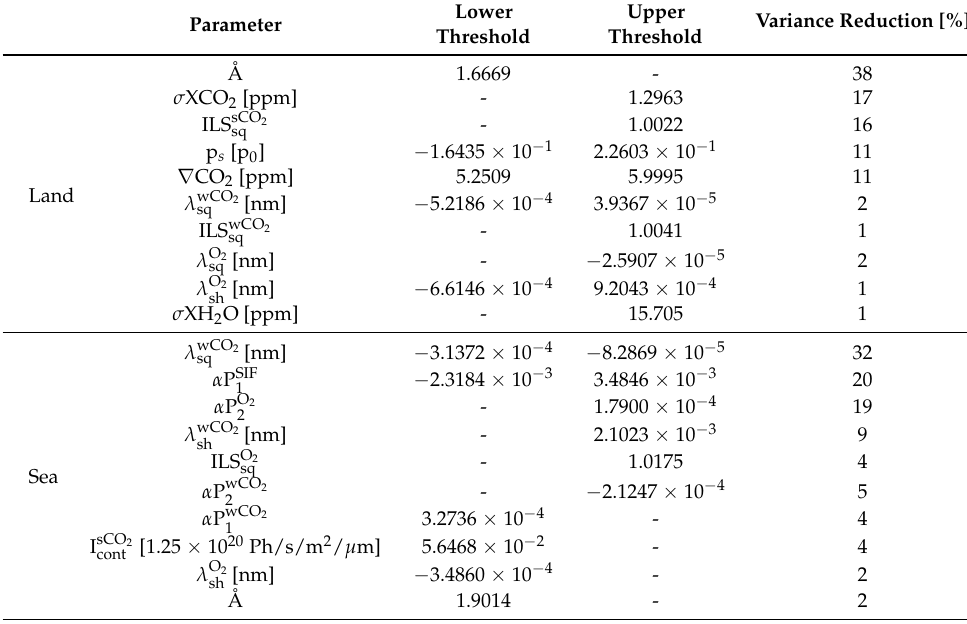
Table 1. Thresholds and prorated variance reduction of the 10 parameters of the potential outliers filter for soundings above land ( top ) and sea ( bottom ). In total, the variance of ∆ XCO 2 is reduced from 2.05ppm 2 to 1.68ppm 2 above land and reduced from 1.22ppm 2 to 1.09ppm 2 above sea. See part 1 [23] and the main text for a description of the individual